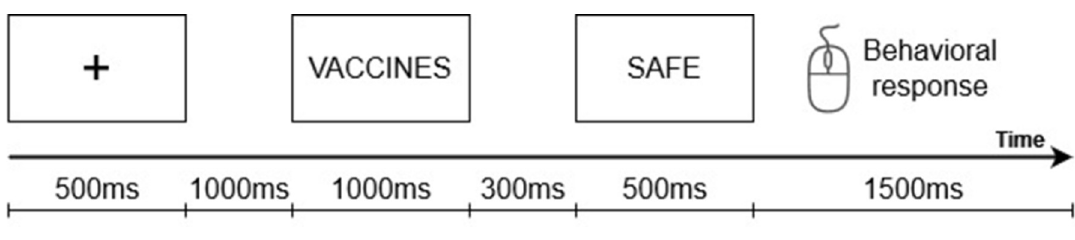
Fig 1. Schematic illustration of a trial in the EEG